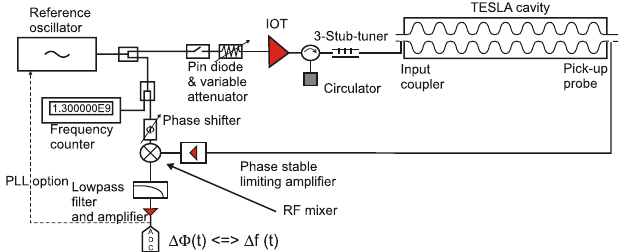
FIG. 4. (Color) This scheme shows the rf setup at HoBiCaT for cw detuning measurements. The cavity is driven open loop by a reference oscillator and its frequency shift detected by the phase shift at an rf mixer between forward and transmitted rf signal. Alternatively, the cavity may be driven closed loop in a phase- locked-loop mode (PLL) by modulating the reference source with the measured phase error